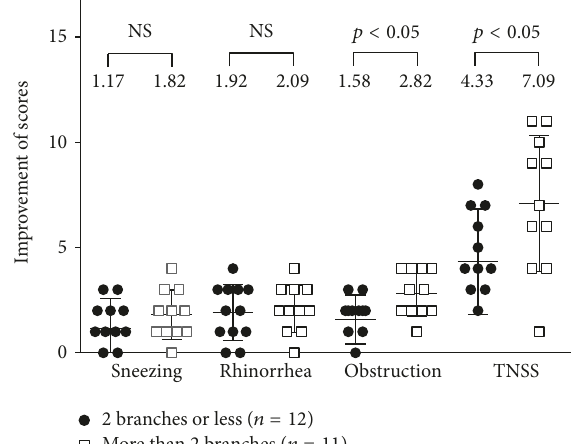
Figure 4: The improvement of each nasal symptom and the TNSS in the group of ≤ 2 branches versus the group of > 2 after surgery. The data were examined with the Mann–Whitney U test. Bars and wings represent mean values with standard errors. NS = no